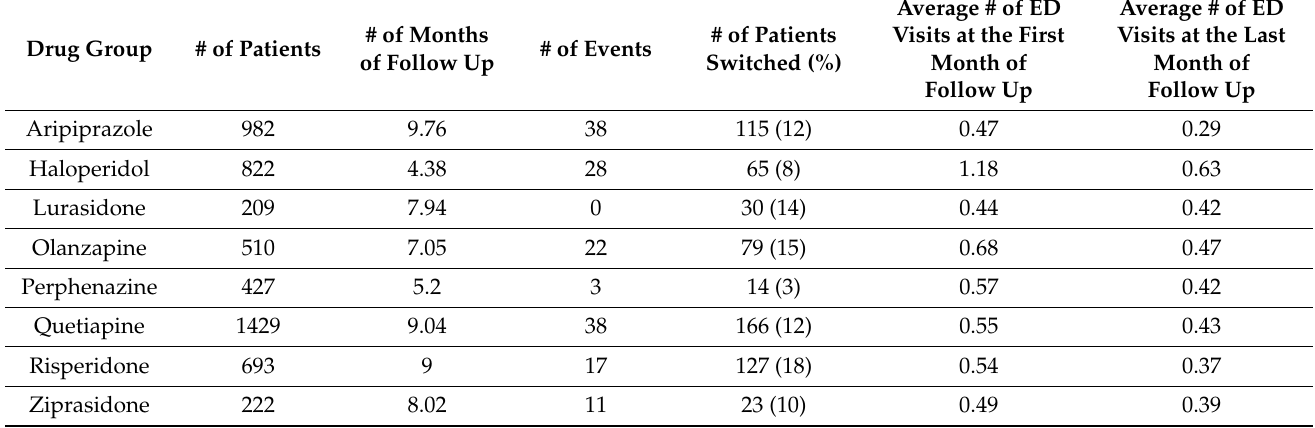
Table A3. Information on Number of Patients Who Switched Their Assignment, and ED Visits at the First and Last Month of Follow